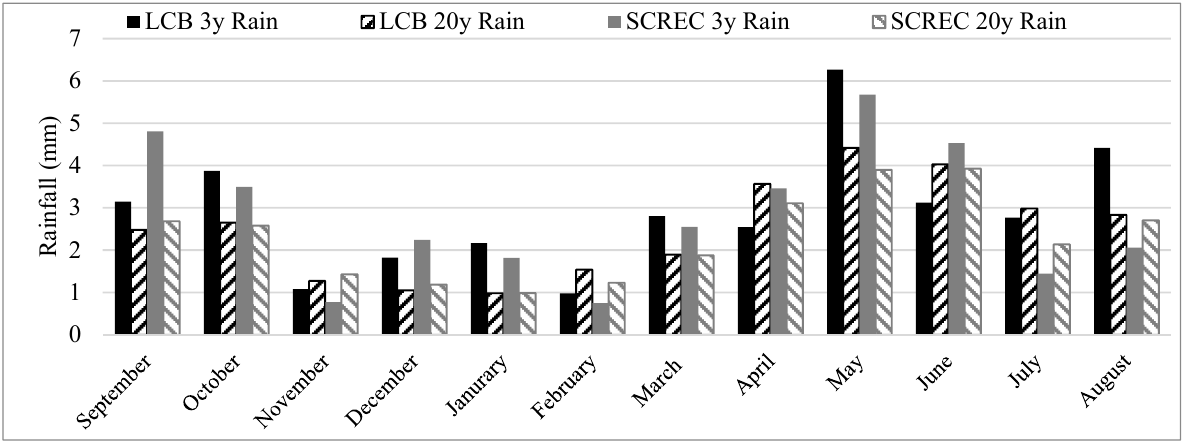
Figure 3. Average monthly rainfall amount (mm) for three years of the study (3 y) and 20-year average (20y) at each location. The three-year average starts in Sept. 2018 through May 2021, 20-year average starts in Sept. 2001 through May 2021.